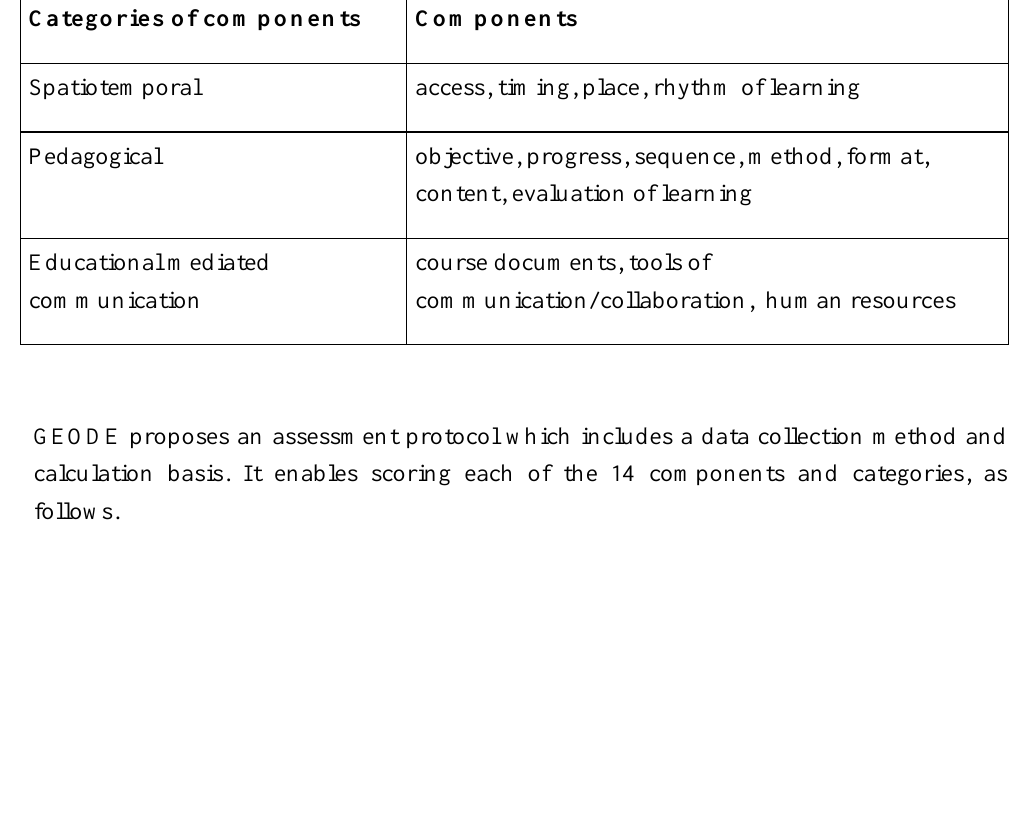
The Three Categories of GEODE Components (Jézégou, 2010a, p. 89) Categories of components